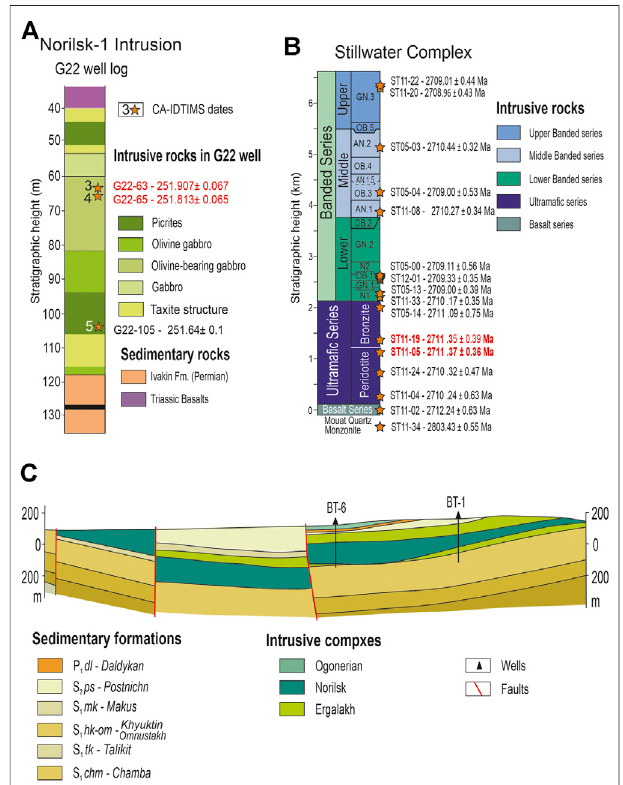
FIGURE 3 | Chronostratigraphic summary of high-precision U – Pb dating results of zircon from intrusive rocks of the mixed superposition (cross- cutting intrusive layers) at Norilsk-1 intrusion and Neoarchean Stillwater Complex of Montana. (A) , distribution of U – Pb ages in well G22, (Distler et al., 1999) Norilsk-1 intrusion [data from Burgess and Bowring (2015)] (B) , Stillwater Complex (Wall et al., 2018); (C) , the relationship of Norilsk and Ergalakh intrusive complexes in Kuramakit area (modi fi ed from Sereda et al., 2020), where the younger Norilsk intrusive complex intruded within and underneath the older Ergalakh